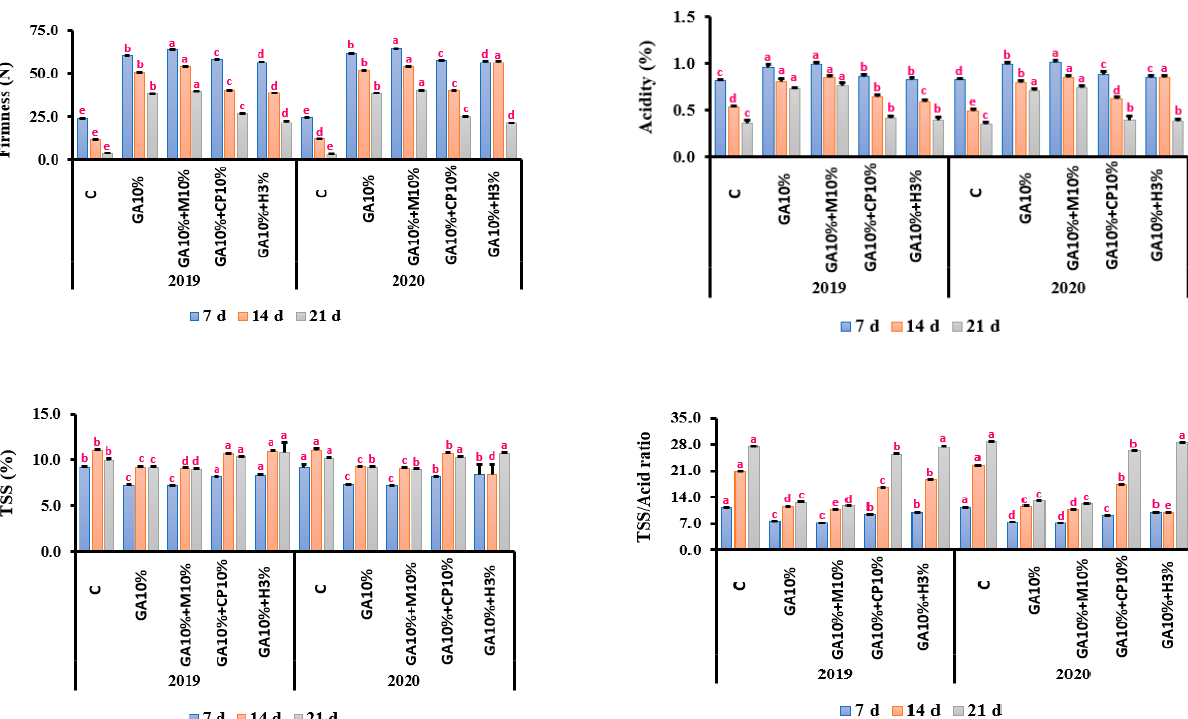
Figure 2. Effect of edible coatings moringa extract, cactus pear, henna and GA, on firmness (N), TSS (%), acidity (%), and TSS/acid ratio of guava during cold storage for 21 days throughout two seasons (2019–2020). The superscript letters, present the significantly between effect of treatments using Duncan’s multiple range